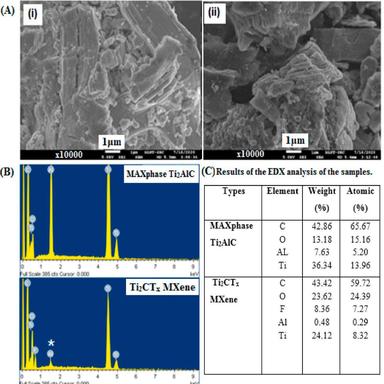
(A) FE-SEM images of (i) Ti2AlC MAX phase and (ii) Ti2CTX MXenes, (B) EDX spectra of weight percentage of MAX phase Ti2AlC and Ti2CTx MXene, (C) Table for elemental weight % and atomic % of MAX phase Ti2AlC and Ti2CTx MXene. \ indicates the reduction of significant Al atomic percentage.